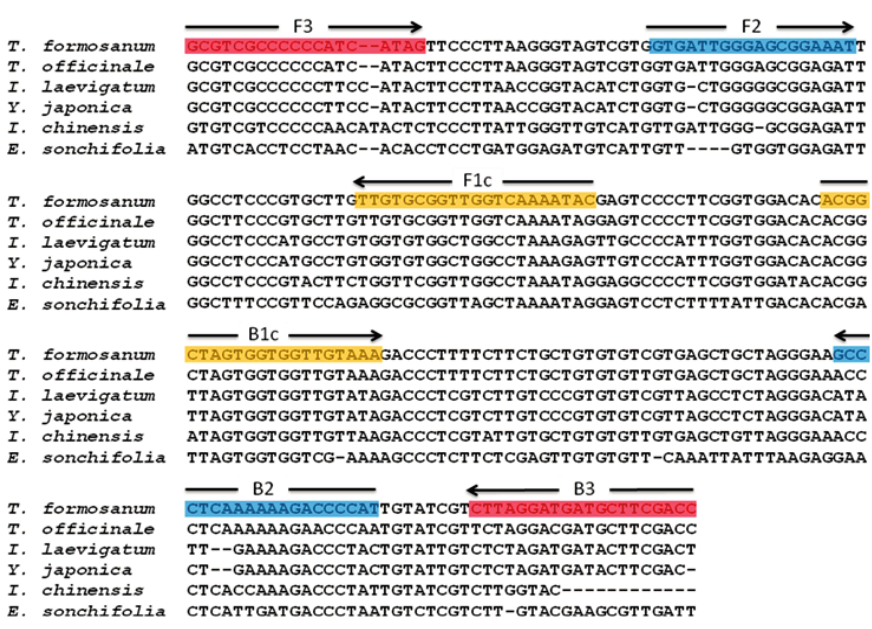
Figure 1. Sequence alignment of the ITS2 of T. formosanum and its adulterants. The five ITS2 sequences of the adulterants of T. formosanum were aligned against T. formosanum . Hyphens (-) denote alignment gaps. The color boxed sequences indicate the regions where the specifically designed LAMP primer sequences are found. The arrow symbols indicate the direction of DNA polymerization from the LAMP